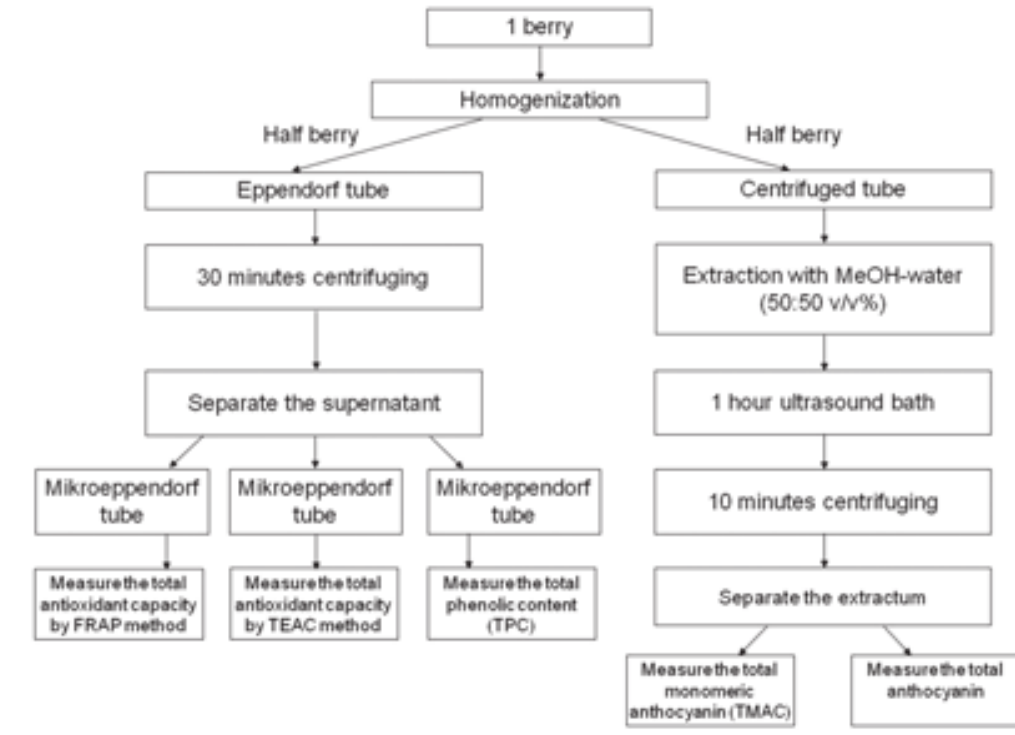
Figure 1. Sample peparation step by